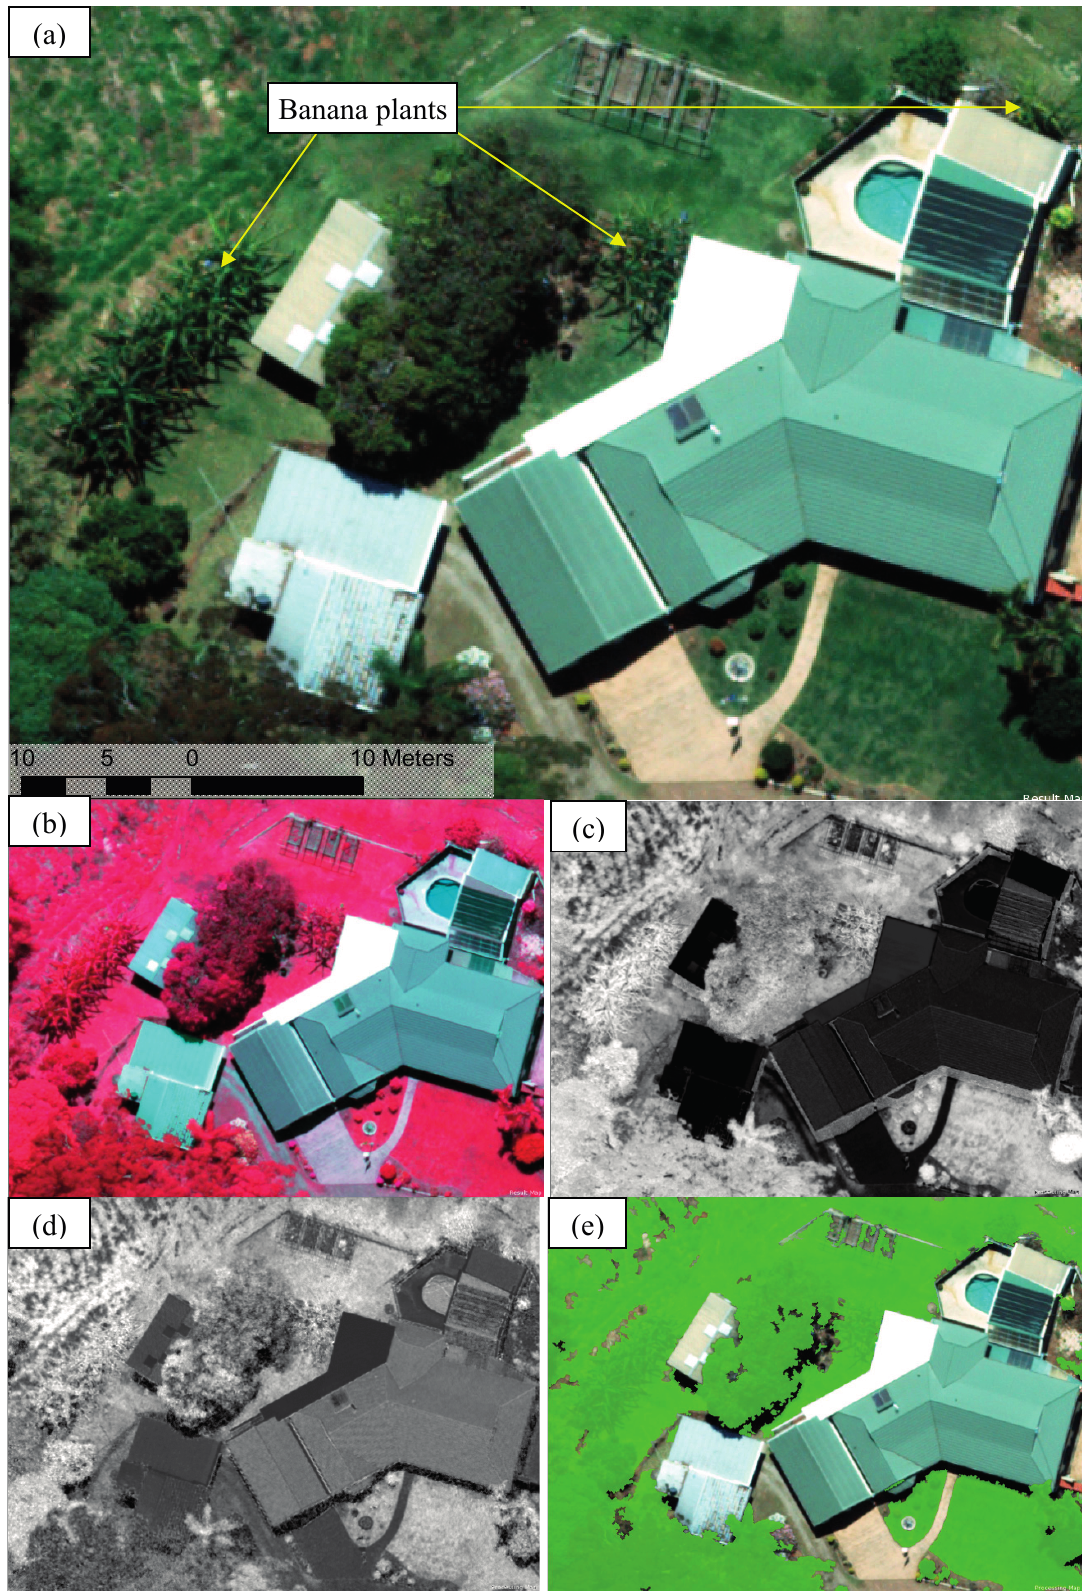
Figure 5. ( a ) True and ( b ) false colour orthophotos; ( c ) the Normalized Difference Vegetation Index ( NDVI) index; ( d ) the Green Ratio index and ( e ) the vegetation (green)